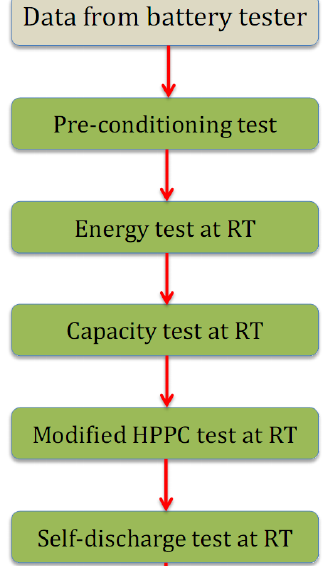
Figure 6. Characterization